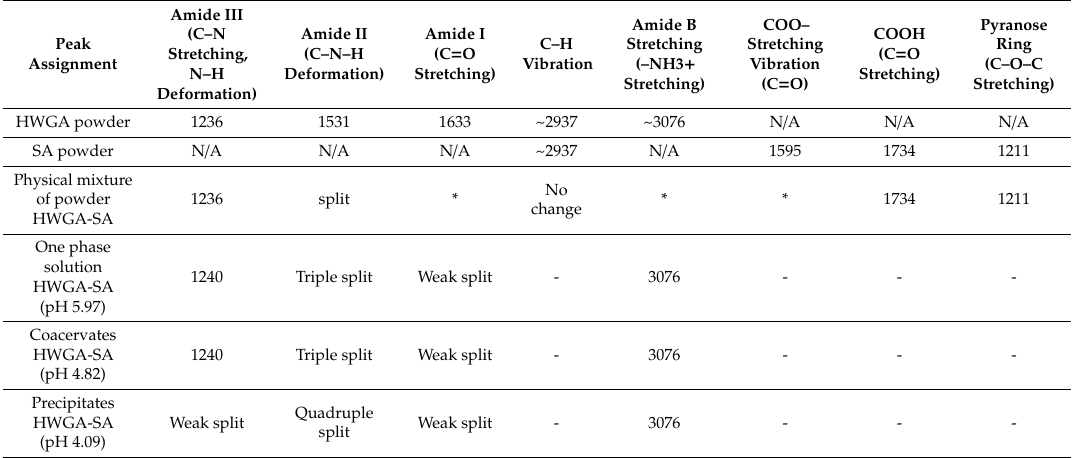
Table 2. Assignments of major bands in FTIR of HWGA, SA, and their mixtures (1:0.4) in various